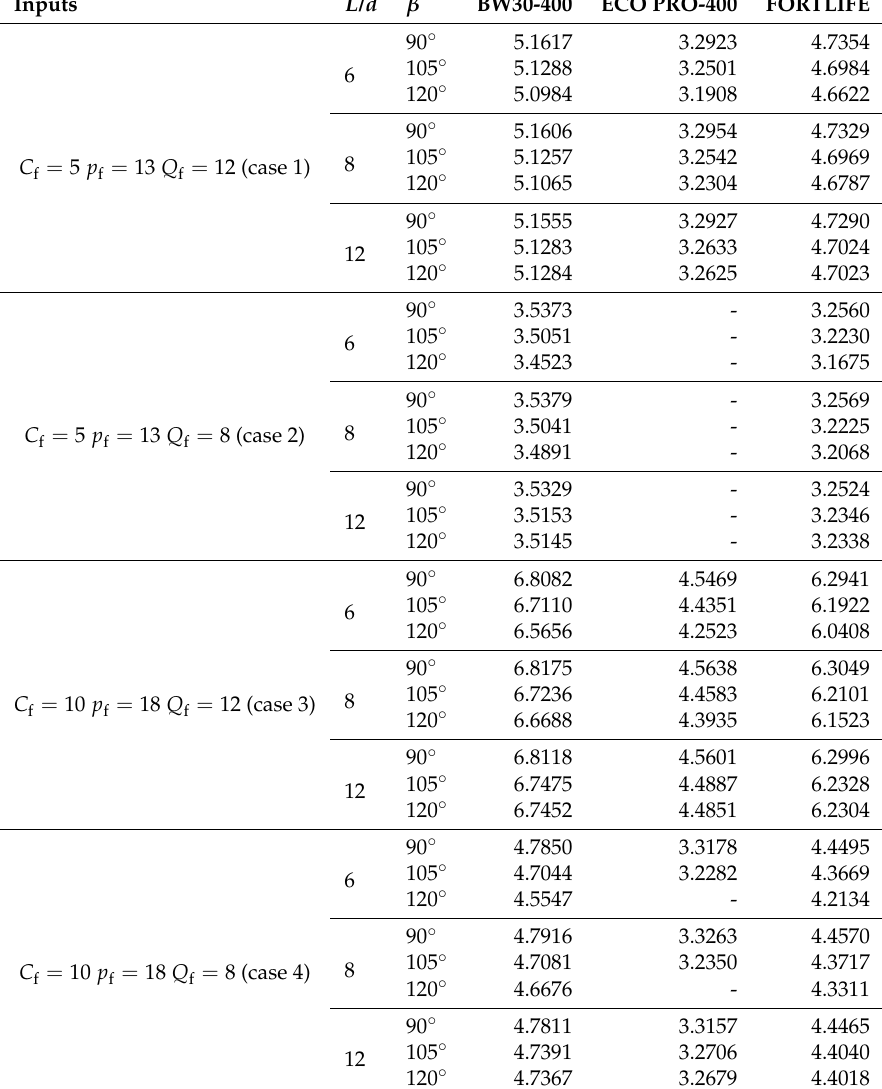
Figure 6. C p of the membrane FILMTEC TM ECO PRO-400 considering different feed spacer geometries, a range of C f , p f = 15 bar and Q f = 11 m 3 h − 1 . Table 4. SEC (kWh m − 3 ) for the three membranes studied with different spacer geometries. Inputs L / d β